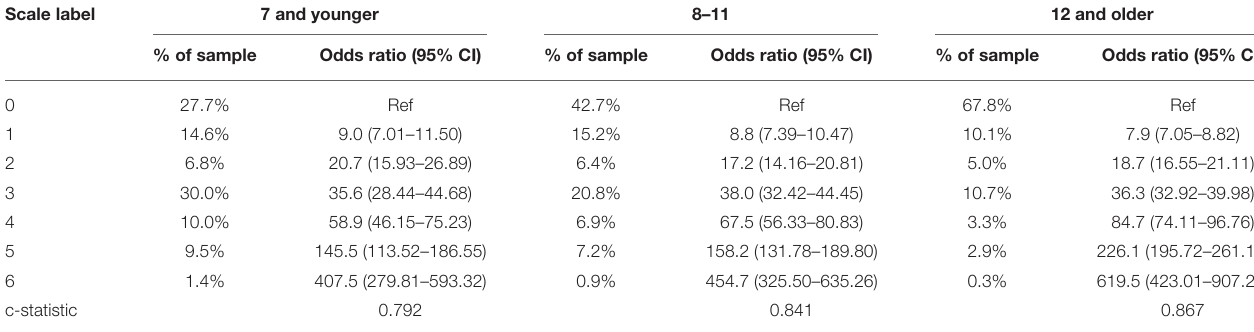
TABLE 3 | Risk of Injury to Others (RIO) algorithm by age, derivation sample ( N = 60,414 screener assessments). Scale